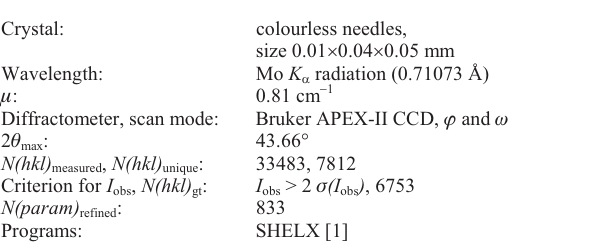
Table 1. Data collection and handling.